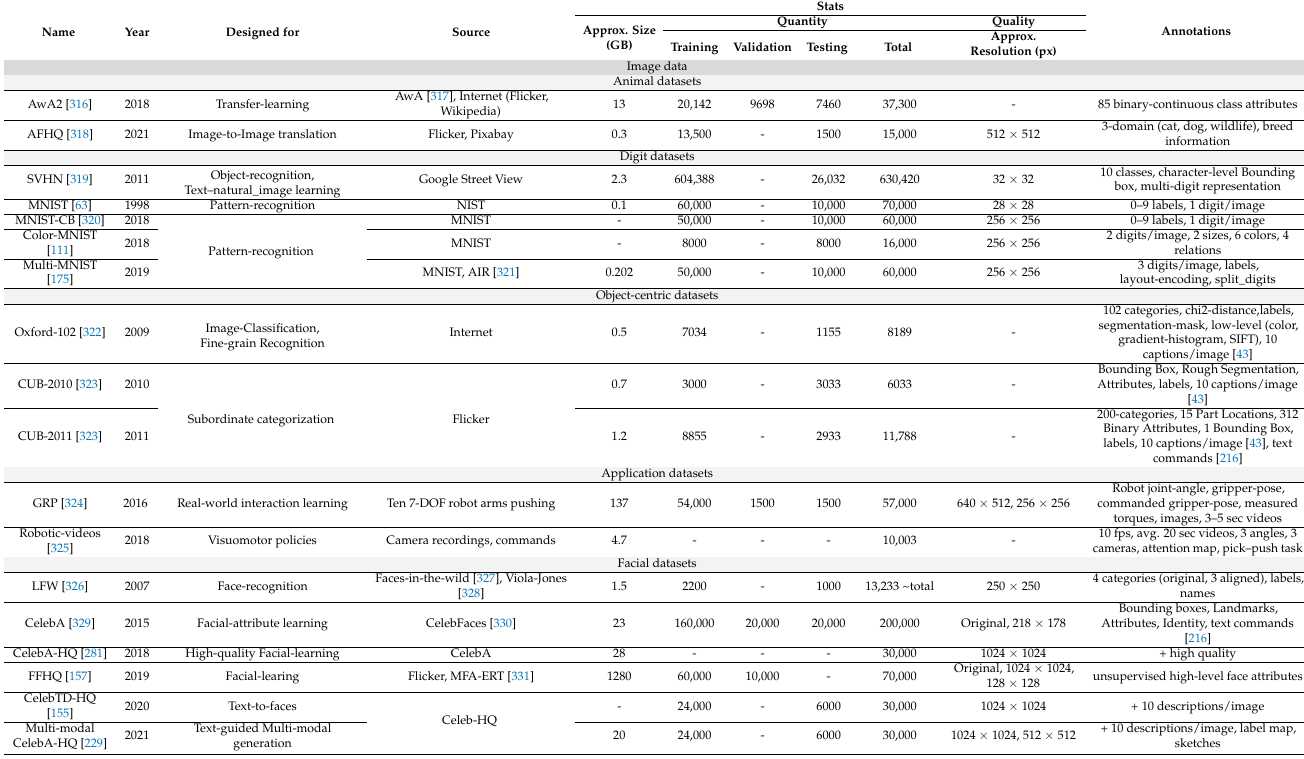
Table 3. Datasets found in the selected